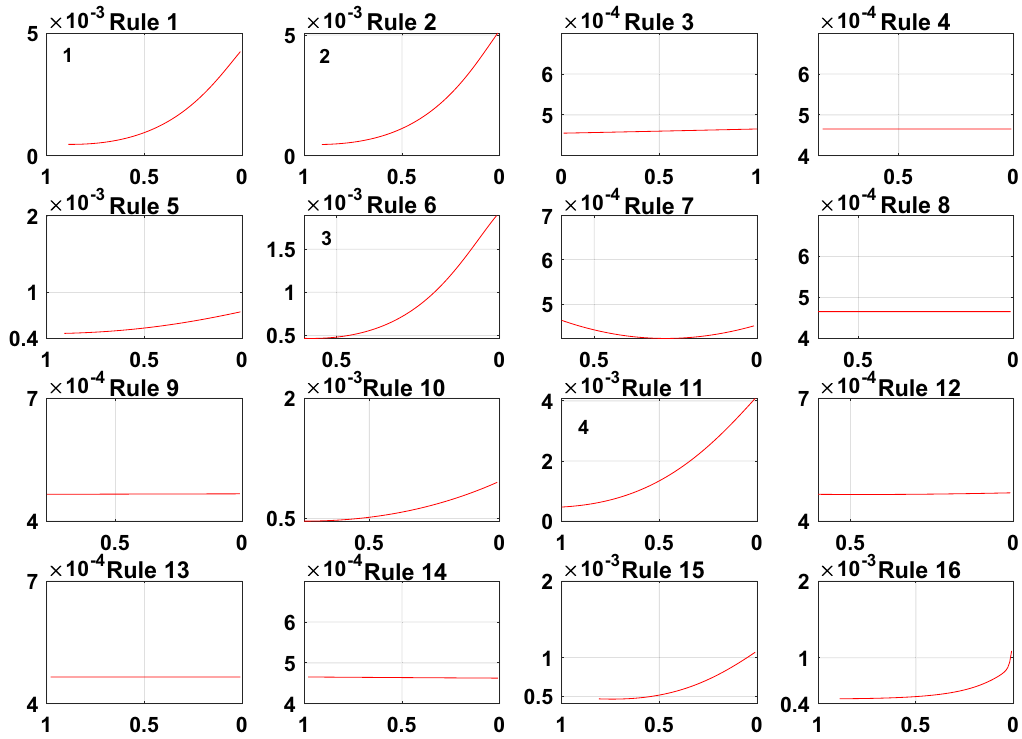
Figure 15. The sensitivity analysis of trained Sub-BRB1 (x-axis represents rule weights, y-axis represents